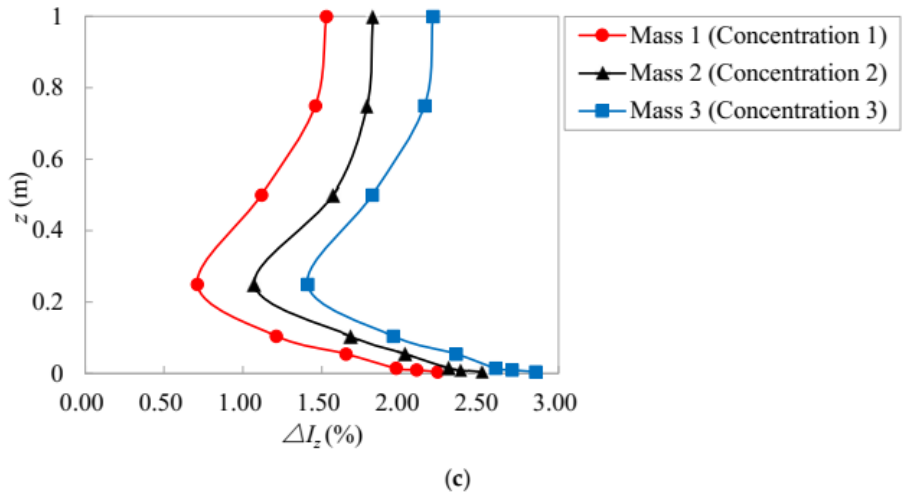
Figure 10. Turbulence intensity impact values: ( a ) At the test wind speed of 10 m/s; ( b ) At the test wind speed of 13 m/s; ( c ) At the test wind speed of 16